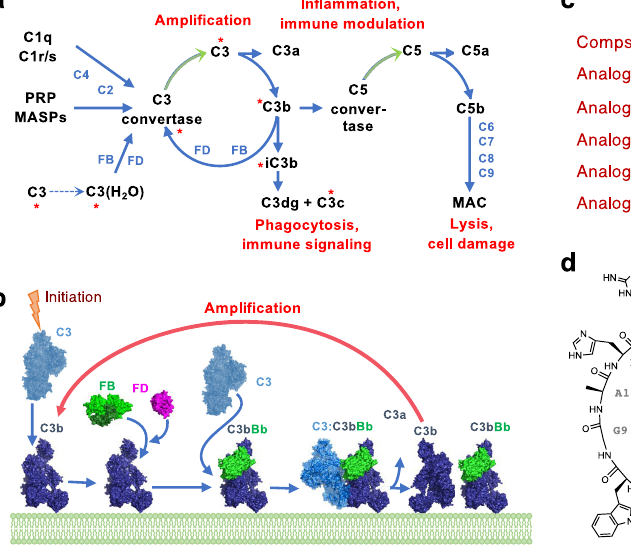
determined by surface plasmon resonance (SPR) are shown. d Comparison betweenthechemicalstructuresofanalogsCp01andCp40,whereinmodi fi cations are highlighted in red. Abbreviations: Ac, Acetyl; FB, factor B; FD, factor D; MAC, membrane attack complex; MASPs, mannose binding lectin-associated